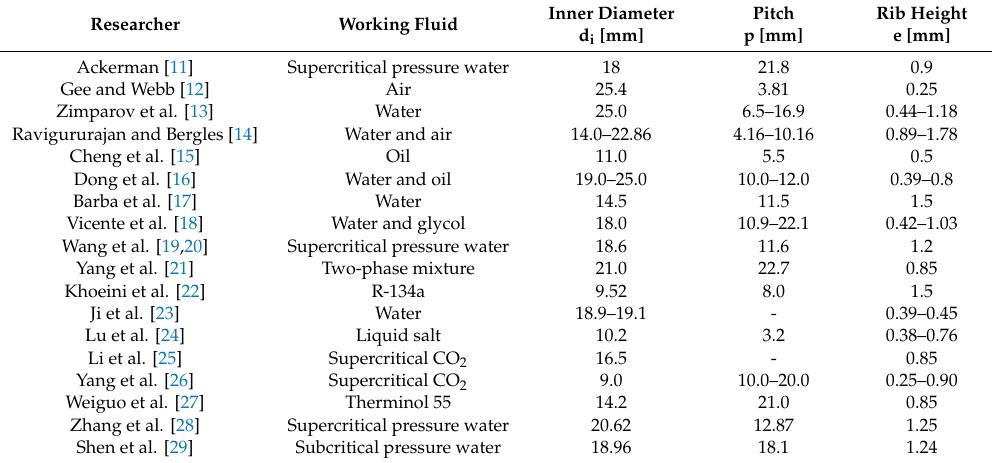
Table 1. Experimental testing to determine pressure losses in internally ribbed